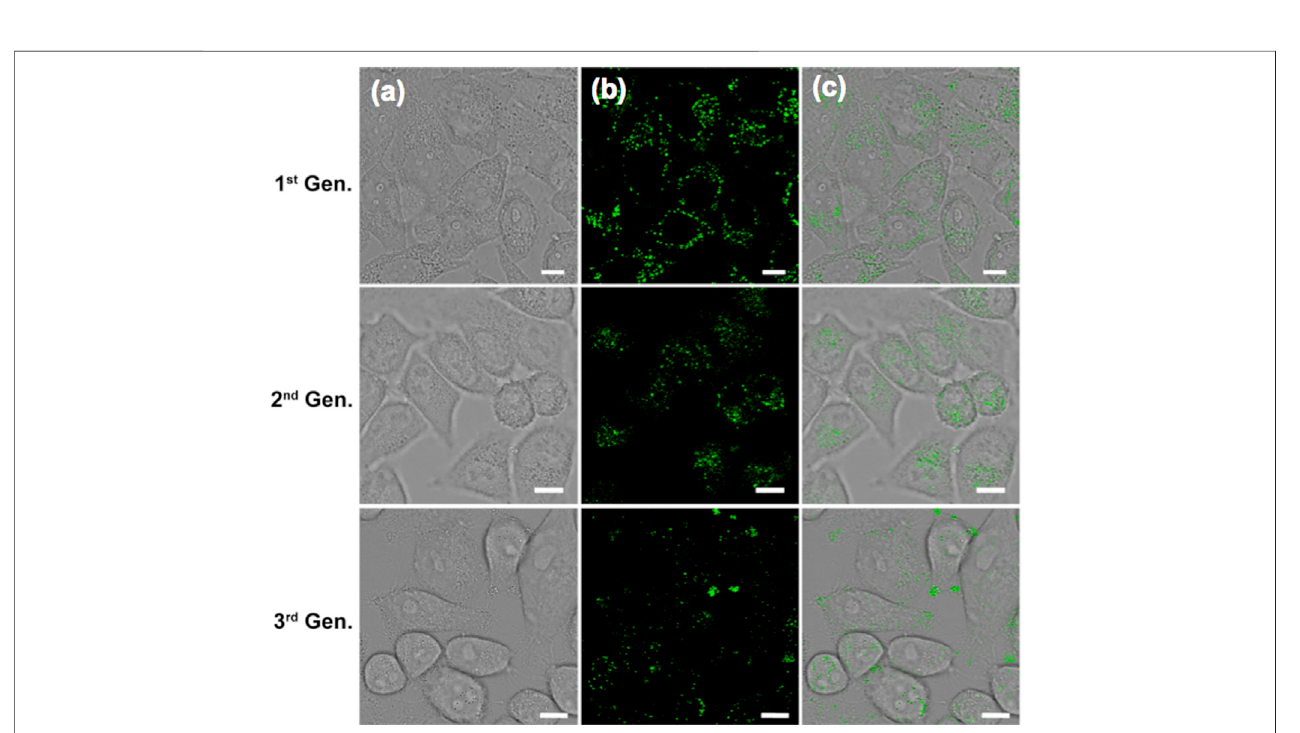
FIGURE 6 | CLSM images of live Hela cells stained with (OMeTPA)2Pyr (1.5 μ g/ml) over different cell generation. Scale bar, 10 μ m.